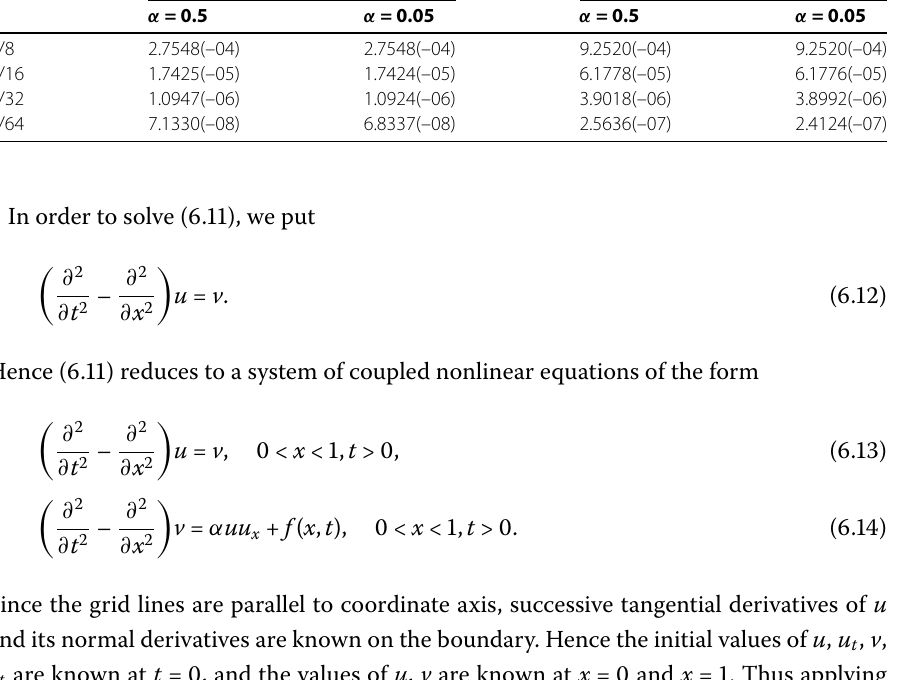
Table 6 Problem 6.5: The maximum absolute errors h Proposed method